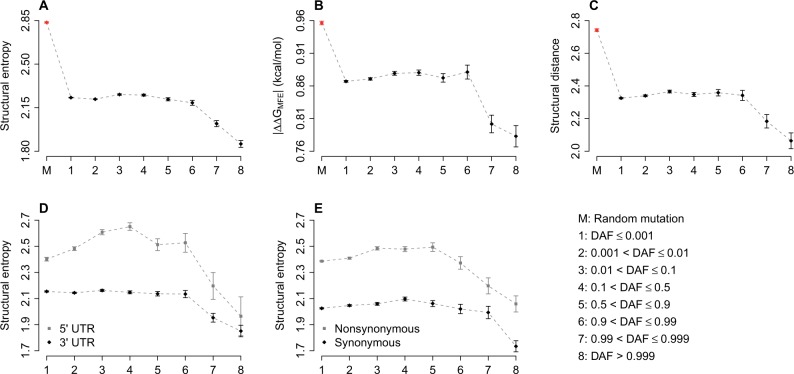
The mRNA structural effect caused by exonic SNPs as a function of DAF. (A) Structural entropy caused by exonic SNPs as a function of DAF; (B) MFE gap between two alleles (|ΔΔGMFE|) as a function of DAF; (C) Structural distance between two alleles as a function of DAF; (D) Comparison of the structural entropy between SNPs located in 5′- and 3′-UTR; (E) Comparison of the structural entropy between nonsynonymous and synonymous SNPs. Each point represents the mean of the corresponding category. Error bars indicate the standard error of the mean.